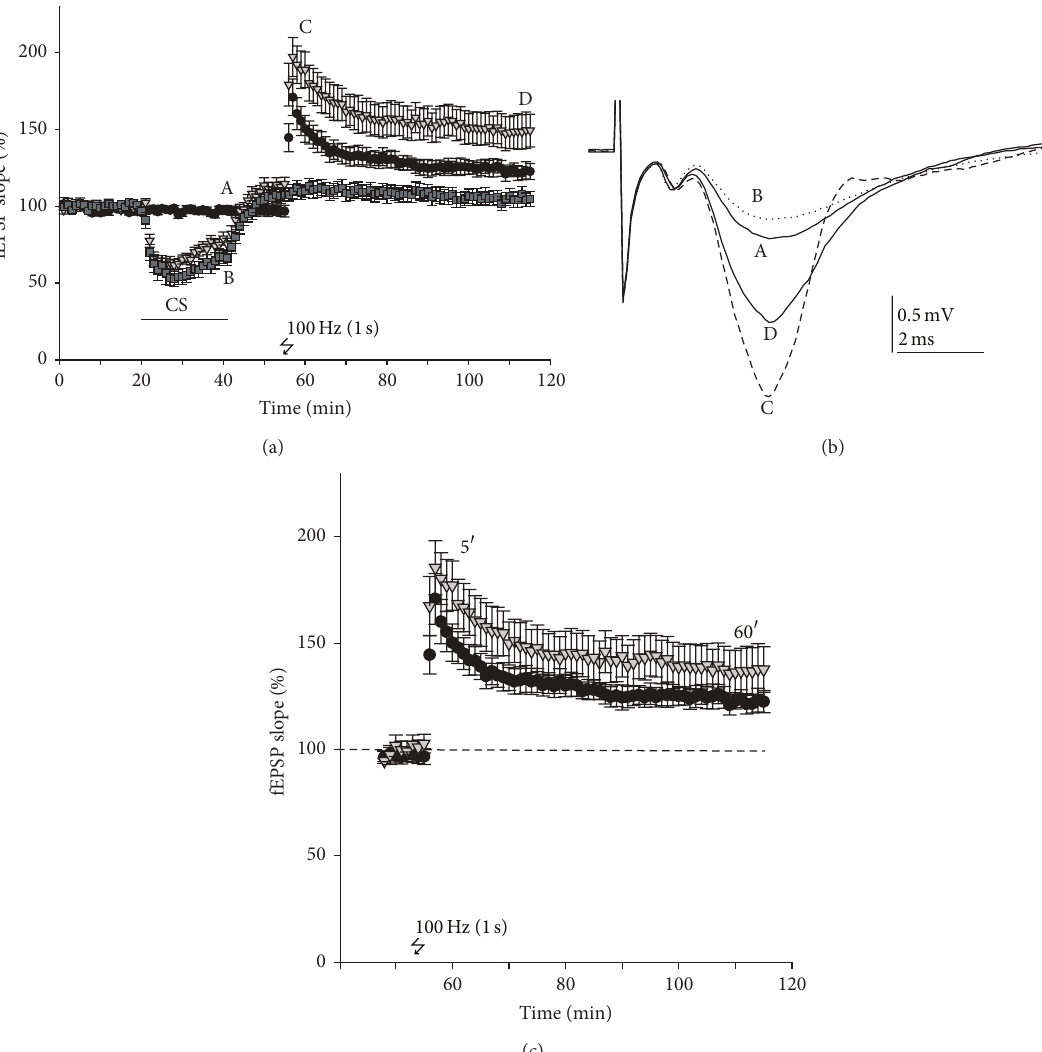
Figure 6: Chondroitin sulfate enhanced short LTP in hippocampal slices. (a) Averaged time-course in control conditions (circle symbol) and CS-treated slices, with (triangle symbol) or without (square symbol) a brief period of tetanization (100Hz, 1s). Data were normalized to the mean value of the 20 min control period and expressed as the mean ± SEM/min ( 𝑛 = 6 – 9 slices). (b) Original traces showing representative fEPSP taken at the times indicated by the letters A (control), B (after CS perfusion), C (CS-treated slice after 2 min tetanisation), and D (CS-treated slice after 60 min tetanisation). (c) Time-course of normalised LTP. The baseline recorded before tetanus was considered as